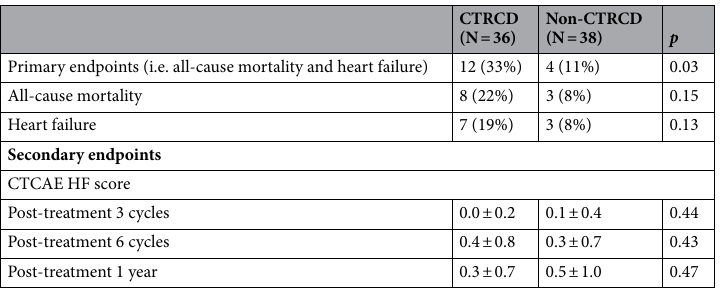
Table 4. Primary and secondary outcomes between the cancer therapy-related cardiac dysfunction (CTRCD) group and the non-CTRCD group. Data are expressed as mean ± SD or number (%). CTCAE HF, Common Terminology Criteria for Adverse Events heart failure; LV, left ventricular.